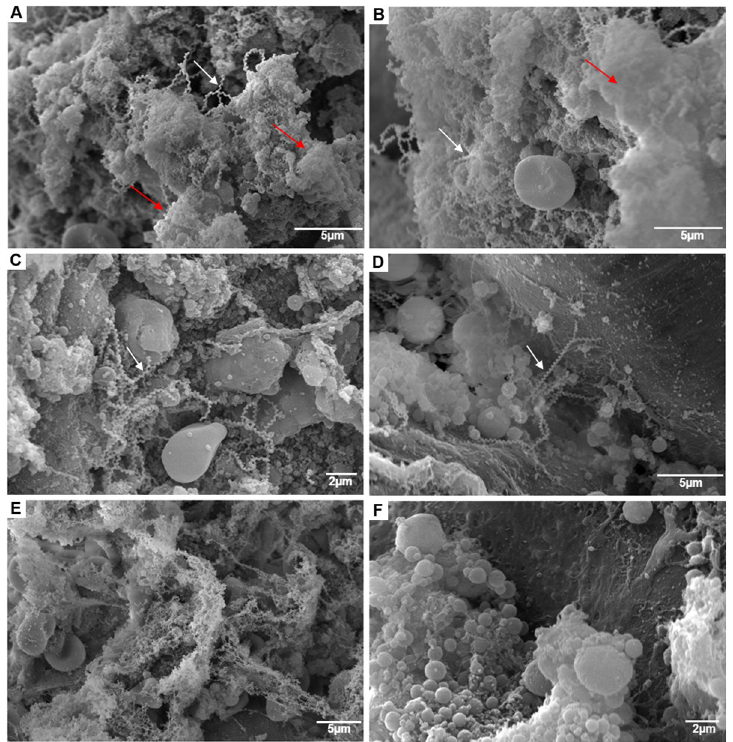
Fig 2. Scanning electron microscopy (SEM) of leptospiral renal biofilm and its matrix in wild naturally colonized Rattus norvegicus . A and B–SEM of colonized kidney with ruthenium red (RR) showed Leptospira a gglomerates (white arrows) surrounded by an anionic exopolysaccharidic matrix (red arrows) inside the renal tubules. C and D– SEM of colonized kidney without RR, where leptospires are evidenced agglomerated (C) or isolated (D), without the presence of the matrix. E–SEM using RR of R . norvegicus negative control. F–SEM without RR of R . norvegicus negative